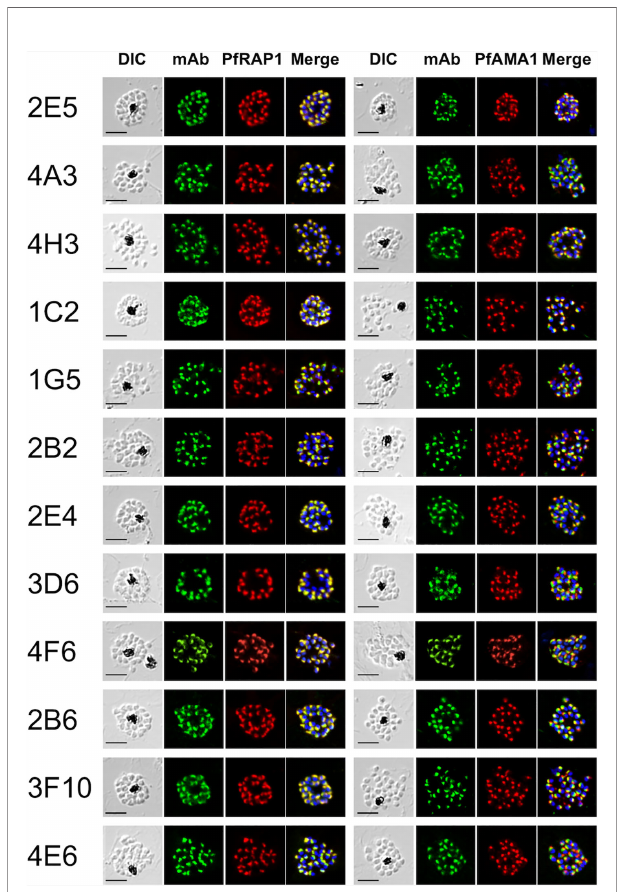
FIGURE 1 | Monoclonal antibodies react with the apical end of P. falciparum merozoites. Mature schizont stage parasites were dual-labeled with each mouse mAb and rabbit antisera against either PfRAP1 (rhoptry body marker) or PfAMA1 (microneme marker). Nuclei were visualized with DAPI in the merged images shown in the right most panels. DIC, differential interference contrast microscopy. Merge, created by merging the IFA and nuclear-staining images. A representative image out of at least three independent experiments is shown for each mAb. Bars represent 5 m